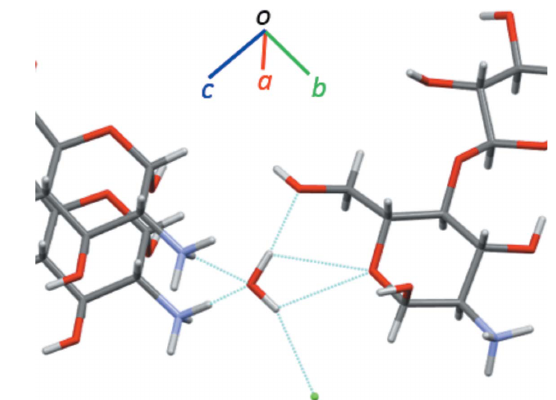
Figure 4 Hydrogen-bonded coordination sphere around the water molecule in the crystal structure of ( I )